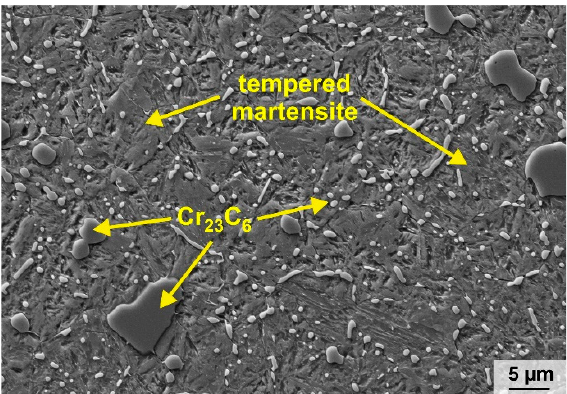
Figure 1. SEM image (SE contrast) displaying the microstructure of the reference cold-work steel X90CrMoV18. Table 1. Nominal and real chemical composition (in wt%) of the novel cast steel with relative stand- ard deviation (RSD in %).